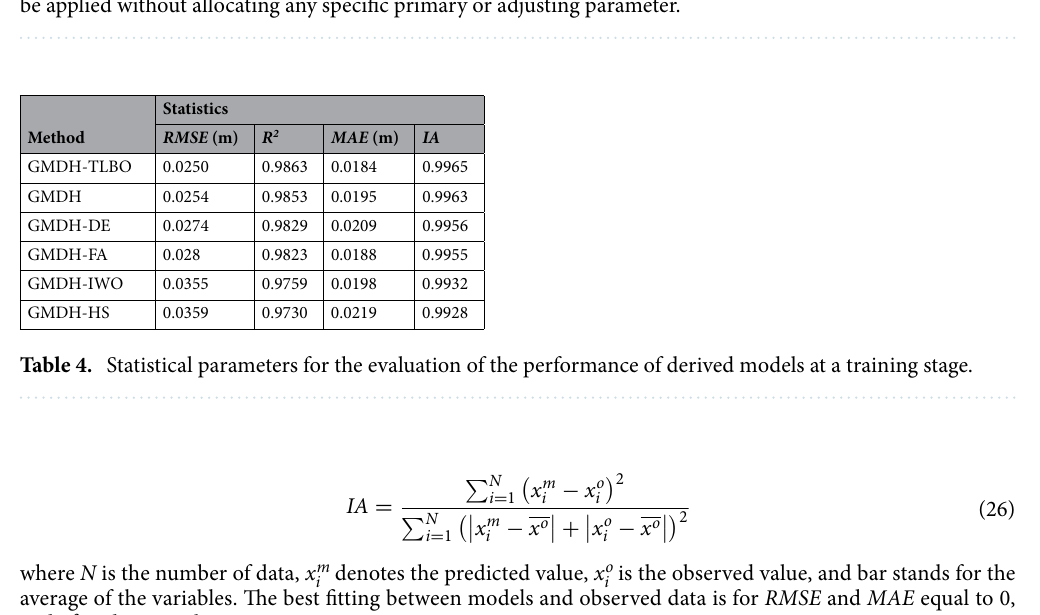
Table 3. Structure of models and initial parameters of meta-heuristic algorithms. *The TLBO algorithm can be applied without allocating any specific primary or adjusting parameter.